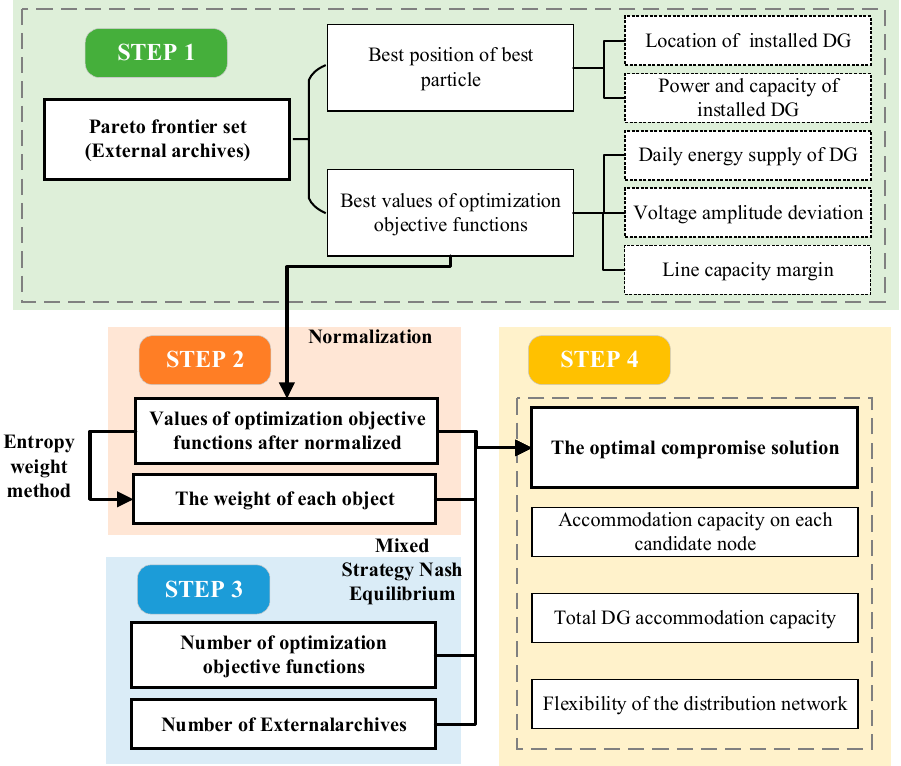
Figure 2. Flow chart of multi-objective optimization of accommodation capacity on distributed generation.